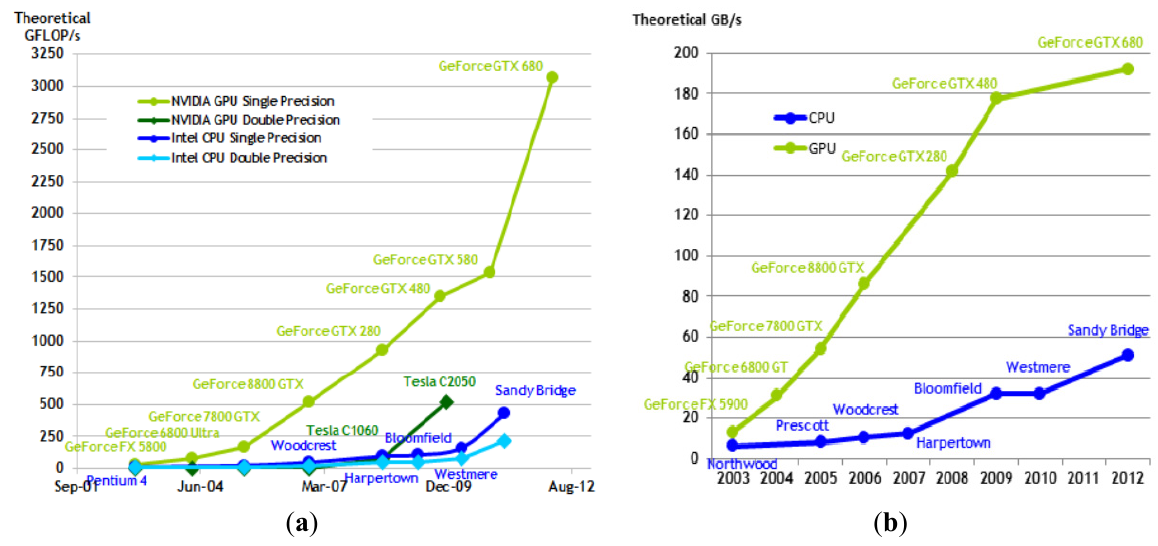
Figure 2. ( a ) Floating-Point Operations per Second for the Central Processing Unit (CPU) and Graphical Processing Unit (GPU). ( b ) Memory Bandwidth per Second for the CPU and